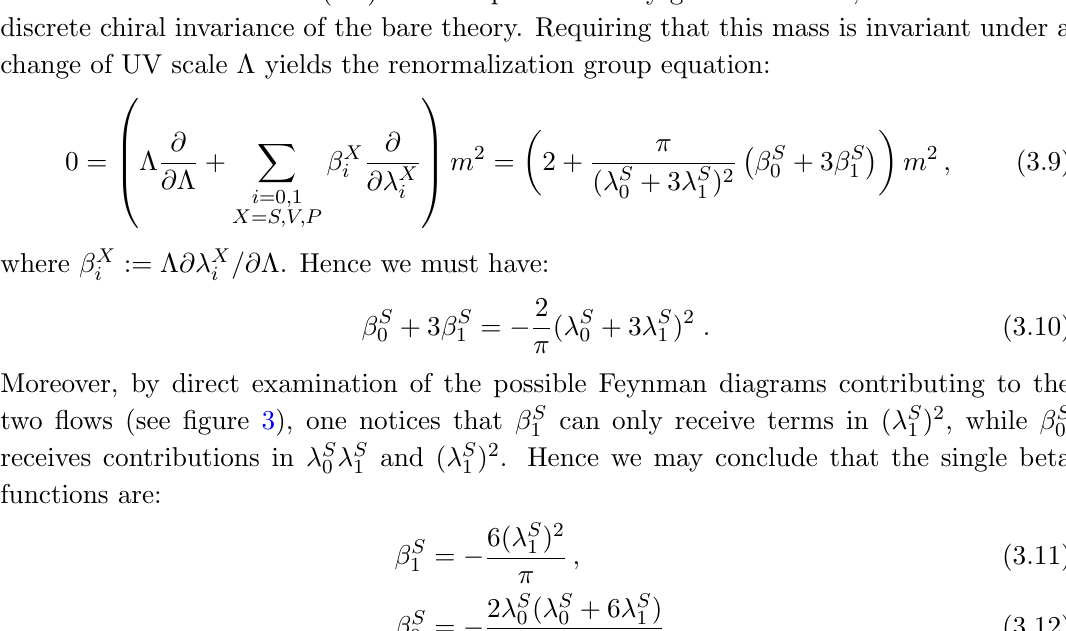
Figure 3 . One-loop Feynman diagrams contributing to (cid:12) S lines represent free